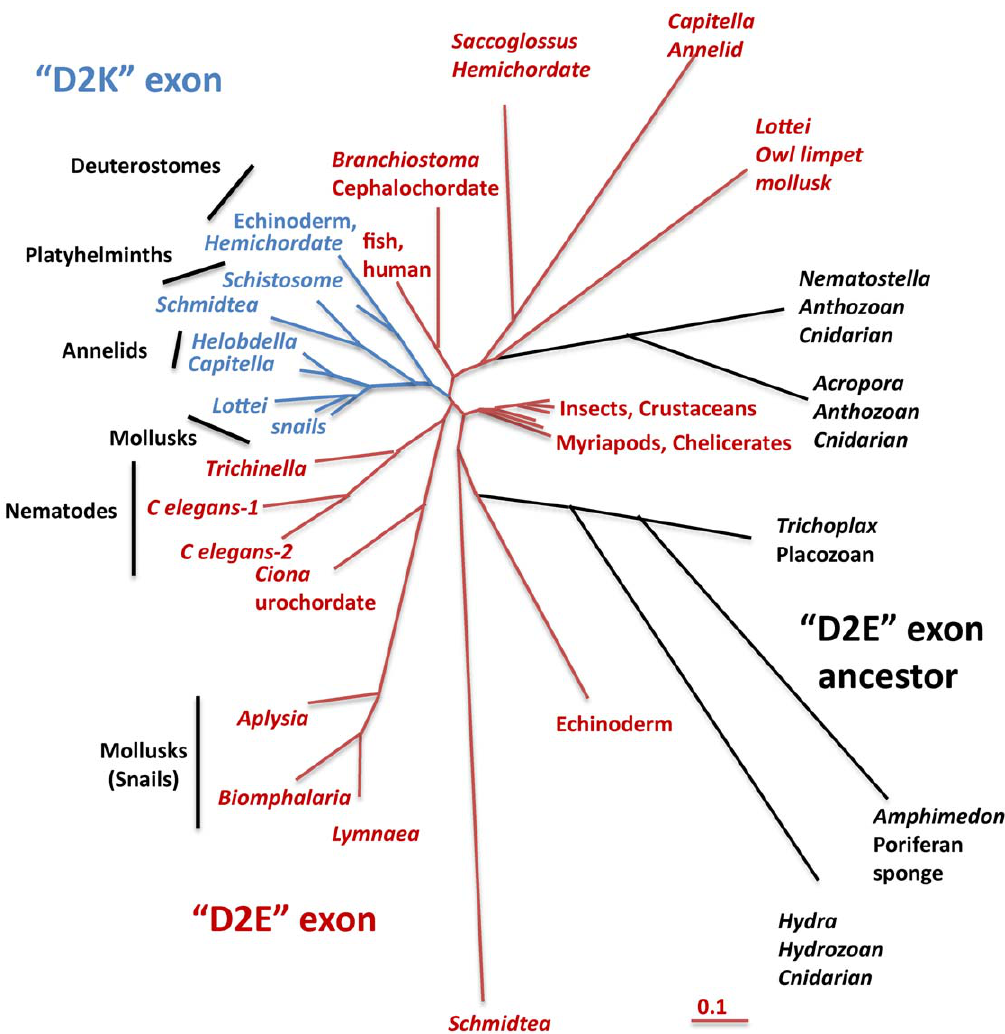
Figure 4. Gene tree of exons 15a/15b indicates that tandem exon 15b, coding for Lys (K) in the selectivity filter, is monophyletic. Exon 15b likely duplicated from exon 15a that codes for Glu (E) in the selectivity filter from an ancestor of early metazoans with a single exon 15a (sponge, Trichoplax , cnidarian), creating an exon 15b with Lys (K). The common root of exon 15b suggests that the dual, mutually-exclusive exons 15a (E) and 15b (K) originated in early metazoans (represented in planarian Schmidtea , a Platyhelminth), evolving once to be subsequently retained in lophotrochozoans (annelids, mollusks) and hemichordates, before being lost in chordates. There was a secondary loss of exon 15a in some invertebrates such as platyhelminth ( Schistosoma ) and annelid ( Helobdella ). No NALCN gene codes for EKKA, so exon 31b (with a K) likely evolved from exon 31a in an arthropod ancestor with an EEEE selectivity filter common to myriapods and chelicerates, with exon 31a being secondarily lost in insects and crustaceans. Exon 31 is shorter and more highly conserved than exon 15, only spanning some of the extracellular turret and the downstream selectivity filter. Exon 31a and 31b barely differ outside of the single E and K residue in the selectivity filter suggesting that exon 31b (K) could have had a separate evolution from an EEEE ancestor in nematodes and